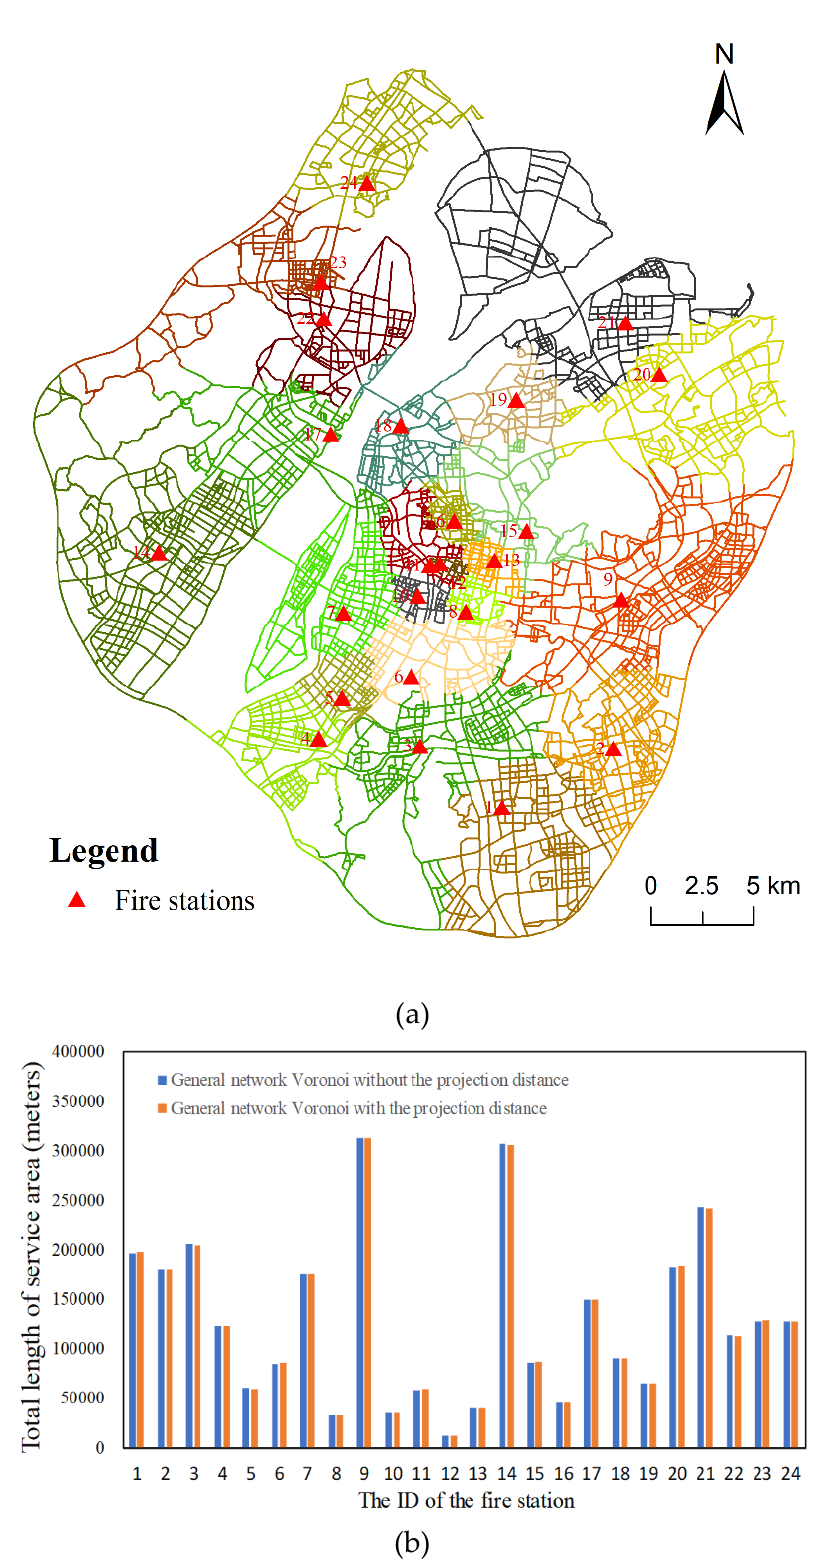
Figure 15. The result of service area delimitation of fire stations using the general network Voronoi diagram with projection distance ( a ) and the difference between the results constructed without projection distance and with projection distance ( b ).